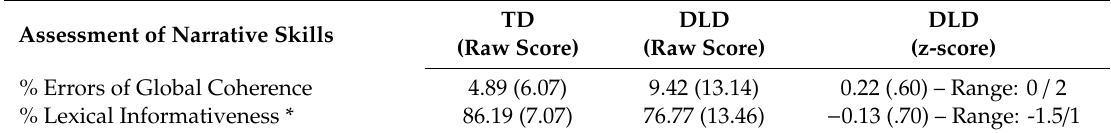
Table 7. Results (means and SDs) of the assessment of narrative skills in the two groups of participants. For children with DLDs, both raw scores and z-scores with respect to normative data are reported in separate columns. For z-scores also ranges are reported. The asterisk (*) shows when the group-related di ff erence in raw scores is